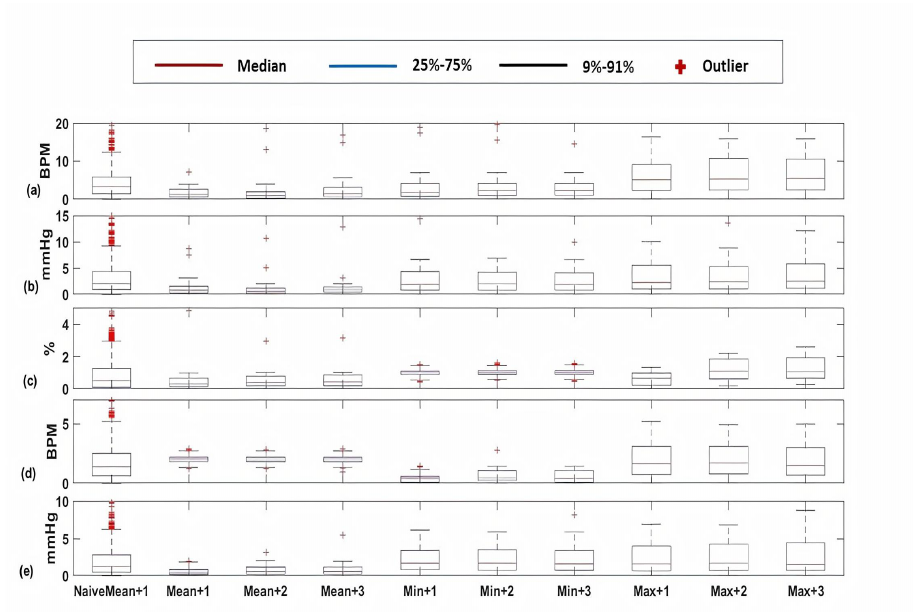
Figure 8. Box-plots of the absolute errors of the Naive predictor at the upcoming hour of the mean value and the proposed algorithm of kNN-LS-SVM of the mean, minimum, and maximum values at the upcoming three hours ( + 1, + 2, + 3 h) for the vital signs ( a ) HR (BPM), ( b ) SBP (mmHg), ( c ) Sp O 2 (%),